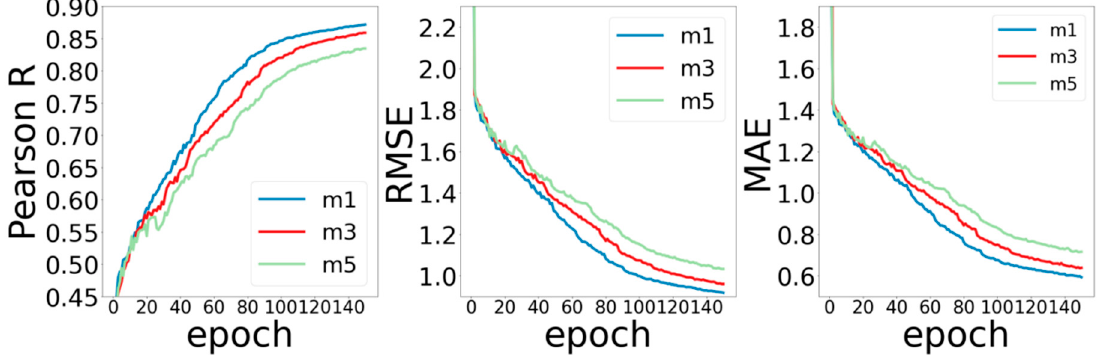
Figure 4. Curves of Pearson R, RMSE, and MAE for different MPNN layers.